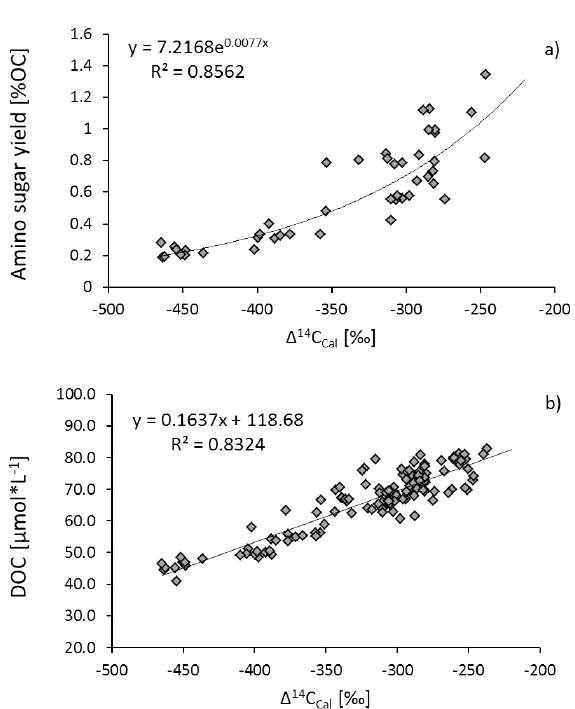
Fig. 9. Correlation and equations of (a) bulk amino sugar yields and (b) bulk DOC concentrations of Atlantic Ocean water and calculated 1 14 C values of the corresponding SPE-DOM. The correlations indicate the reasonability of the trend in 1 14 C Cal . The exponential relation between the amino sugar yield and 1 14 C Cal also suggests that a fraction of the youngest and most bioavailable compounds was not recovered by SPE or was not detected by FT-ICR MS